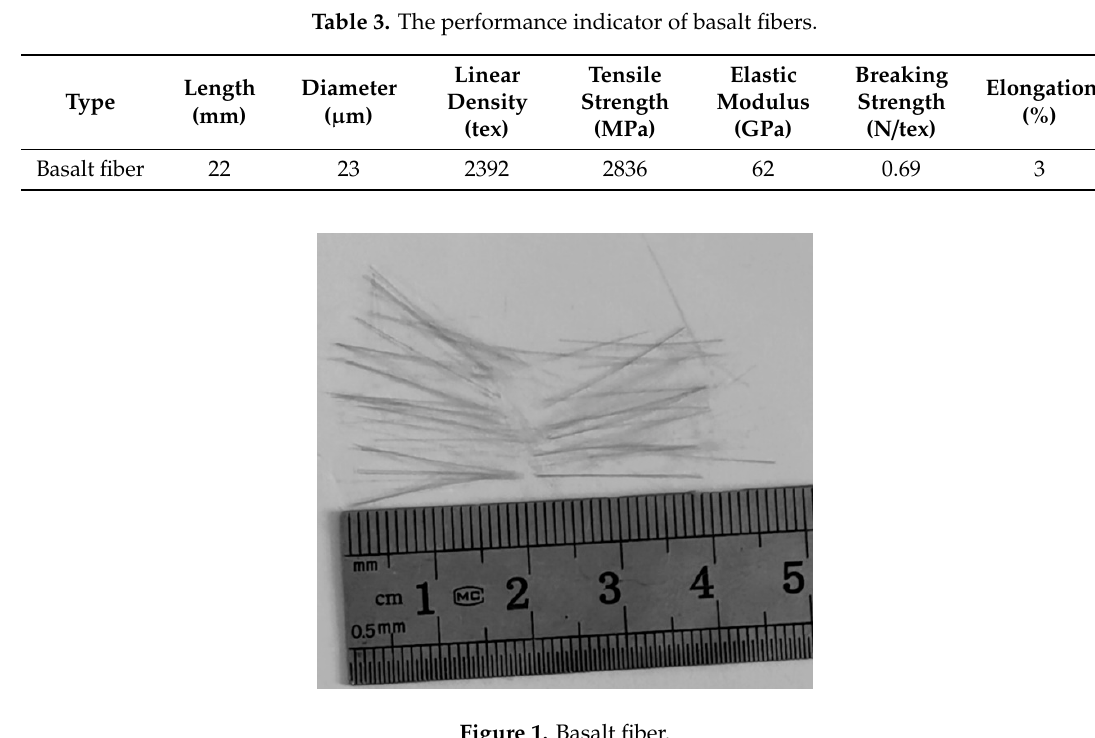
Figure 1. Basalt fiber.